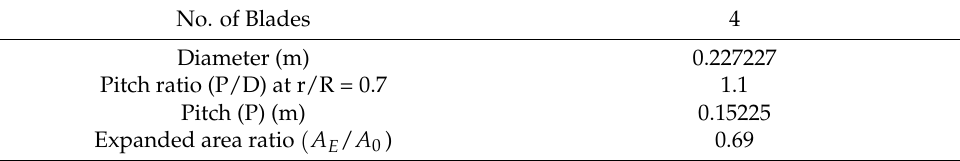
Table 1. INSEAN E779A principal